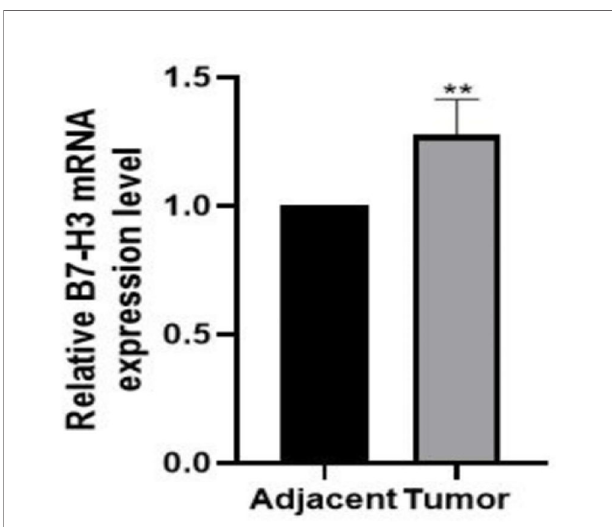
FIGURE 2 | Overexpression of B7-H3 in LSCC tissues compared with noncancerous tissues. B7-H3 mRNA was tested by qRT-PCR, relative to the